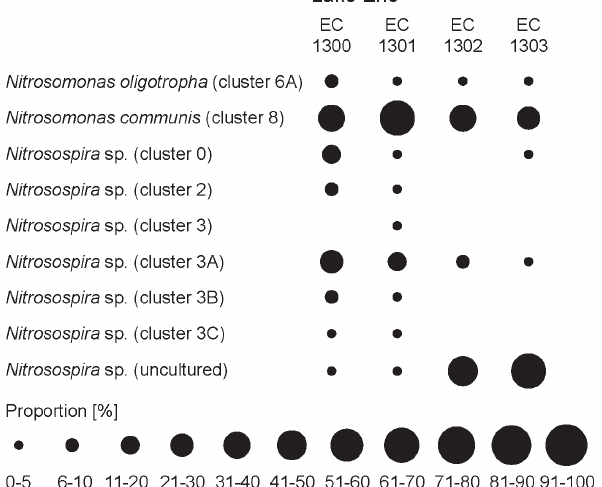
Figure 5. Relative frequency [%] of the AOB in the different phylogenetic groups. Representative sequences were picked based on 98% identity, aligned in ARB and assigned to phylogenetic groups.